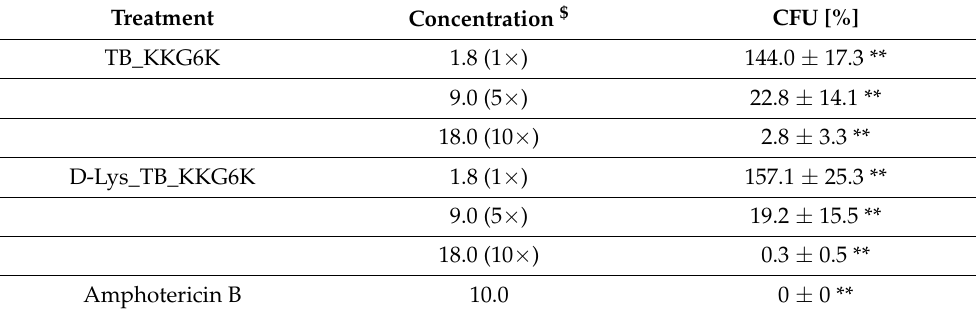
Table 2. Survival of sessile C. albicans cells after exposure to the TB peptide analogs for 24 h § . Treatment